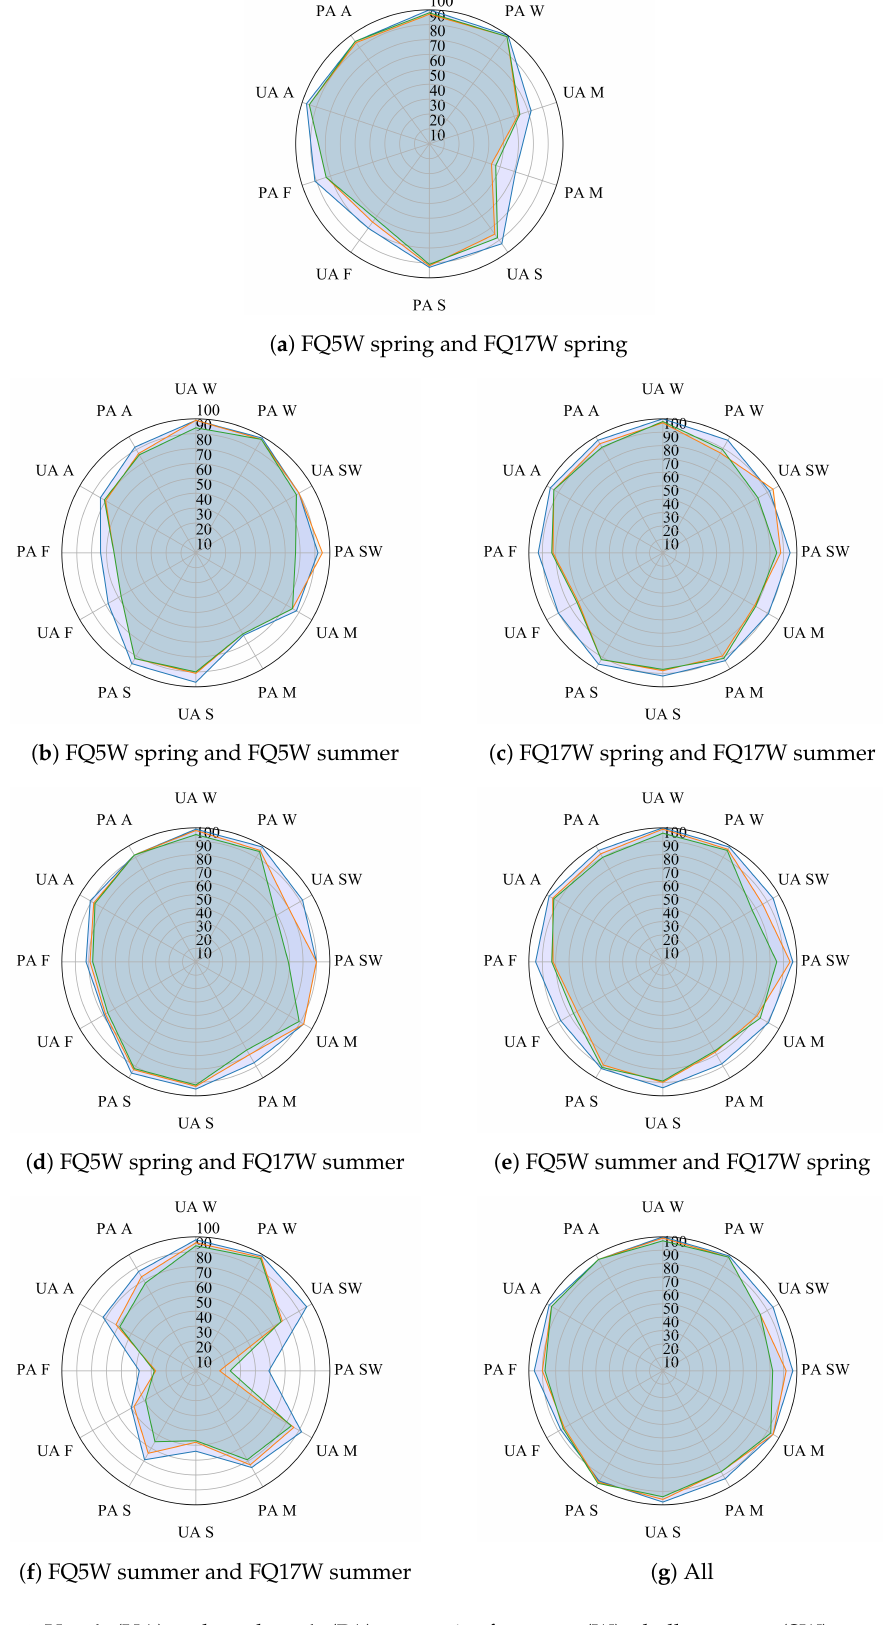
Figure 4. User’s (UA) and producer’s (PA) accuracies for water (W), shallow water (SW), marsh (M), swamp (S), forest (F), and agriculture/non-forested (A) for models based on multi-angle/temporal QP (blue), CP medium (orange), or CP high resolution (green)